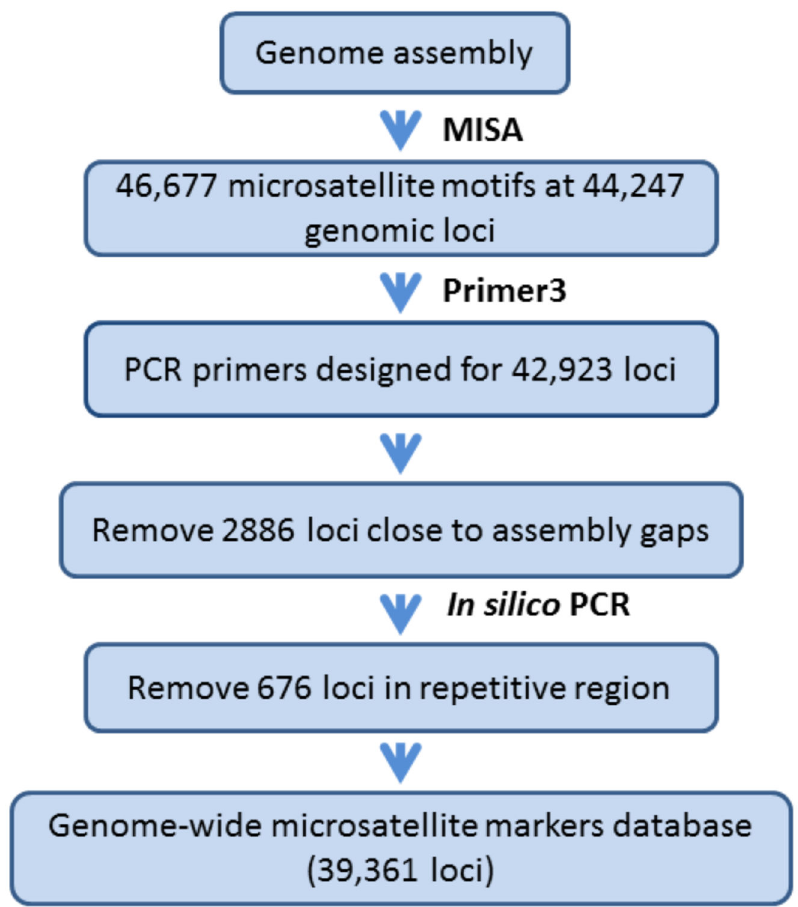
Figure 1. Flow chart describing the bioinformatics pipeline used to construct a genome-wide microsatellite marker database for Anisogramma anomala . See text for detail. doi: